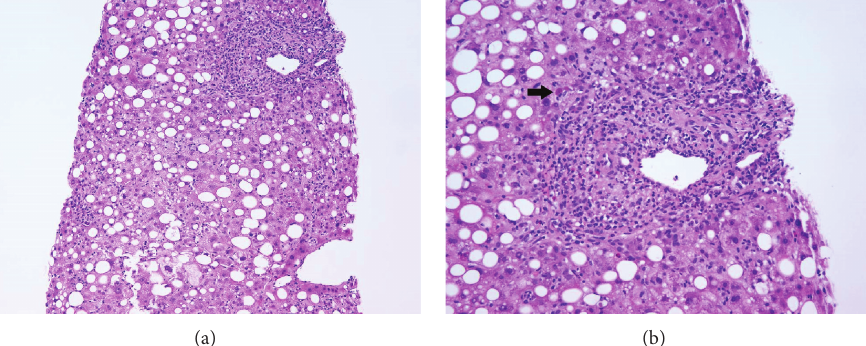
Figure 2: Low magnification of the liver biopsy showing histologic features of a panacinar hepatitis with moderate mixed portal and lobular inflammation ((a) Hematoxylin and Eosin, 100x). Higher magnification of the mixed portal inflammation with lymphocytes, plasma cells, and eosinophils with foci of lobular injury with an acidophil body (arrow) ((b) Hematoxylin and Eosin,